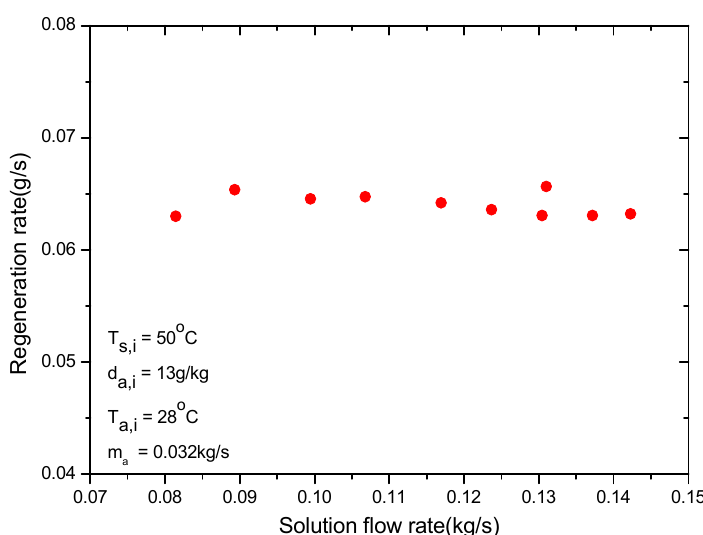
Figure 6. Influence of solution flow rate on regeneration.